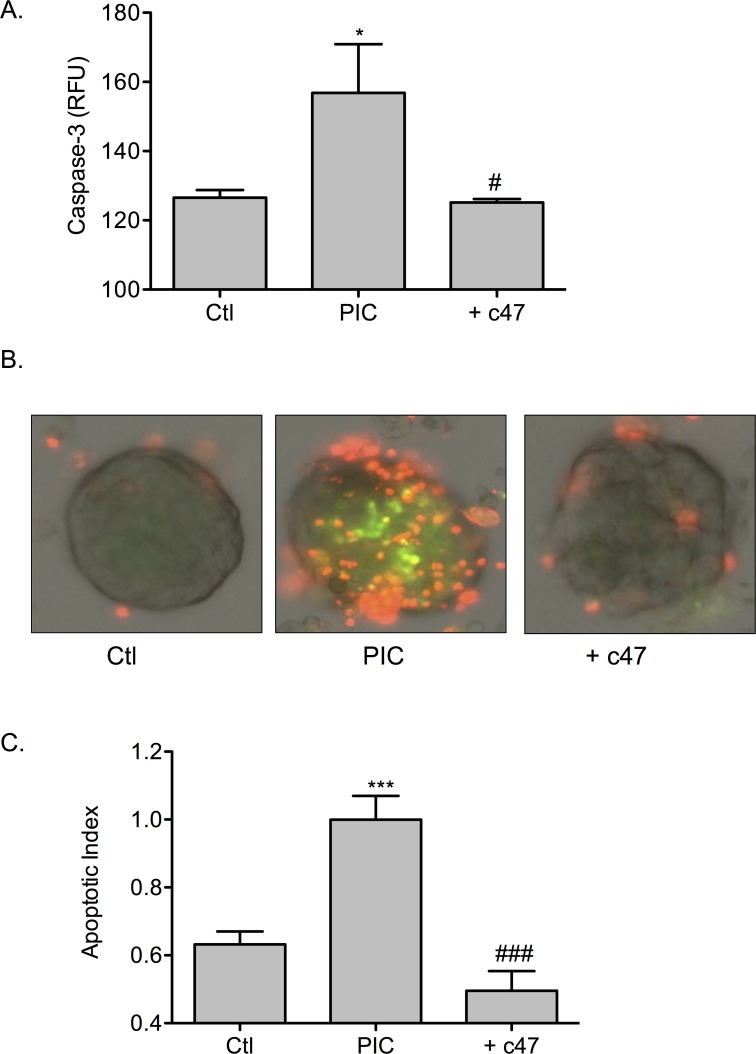
c47 confers protection to mouse islets from PIC-induced apoptosis.(A) PIC-induced caspase-3 activation in the absence or presence of 50μM c47 in mouse islets. Graph shows pro-caspase-3 cleavage. (B) Apoptosis was measured in PIC-treated islets without or with 50μM c47. Cells were examined microscopically following labeling with YO-PRO-1 (green) and PI (red). Representative images are shown for untreated (Ctl), PIC-treated, or PIC with 50μM c47 respectively. (C) Graph shows quantified apoptotic index. * p < 0.05, *** p < 0.001 relative to ctl, # p < 0.05, ### p < 0.001 relative to PIC and n > 3.